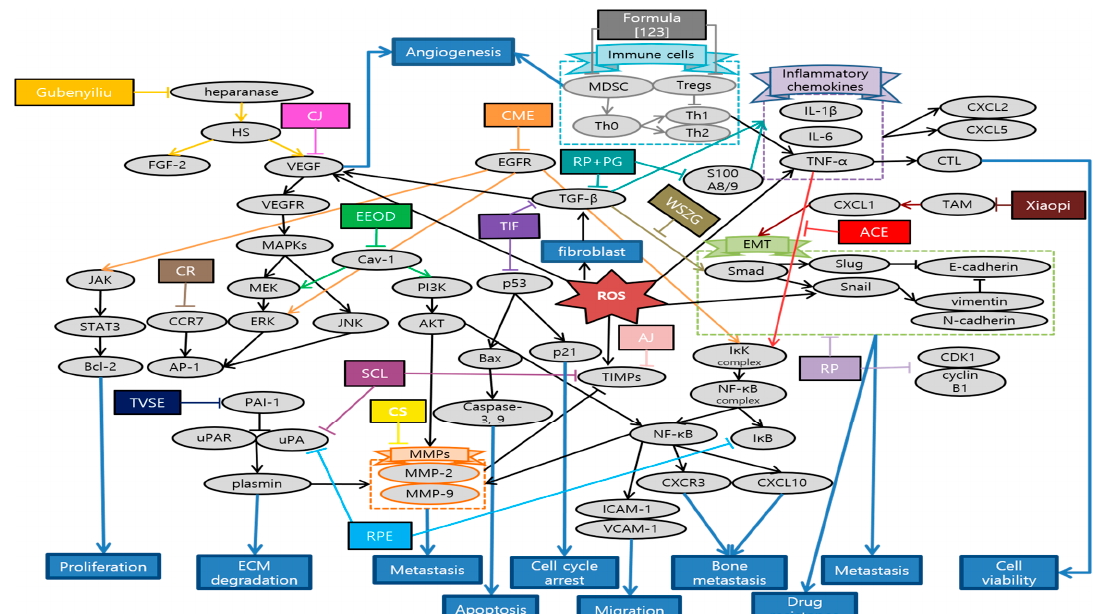
Figure 5. Schematic diagram of anti-metastatic mechanisms of herbal medicine in breast cancer: Herbal medicine suppress metastasis by blocking a series of EMT-related processes which starts with TGF- β 1 and sequentially provoke Smad, Snail, twist, N-cadherin, and, etc. CXCL also mediates EMT which contributes to metastatic micro-environment formation. Moreover, herbal medicine can suppress the expression of MMPs, which play multiple key roles in facilitating the metastasis of tumor cells by direct or indirect pathways. In the latter, MMP-9 is stimulated by various pathways such as AKT/ERK, NF- κ B, STAT3, CCR7-AP-1 pathway, mRNA modulations of uPA and TIMPs. AKT/ERK pathways are also stimulated by Cav-1 and VEGF which is the onset of angiogenesis. On the other hand, NF- κ B induced by TNF- α can activate MMPs, as well as metastasis related factors such as CXCR3-CXCL10, ICAM-1 and VCAM-1. Besides, herbal medicines also stimulate cancer cell apoptosis and cell cycle arrest which are usually mediated by activation of ROS and caspase-3. Expression of CDK1/cyclin B1 and p21 stimulated from p53 were related with cell cycle arrest and apoptosis. Meanwhile, there are two opposite ways in which herbal medicine controls the immune response as anti-metastatic mechanisms. First of all, excessive inflammatory responses create a favorable environment for cancer metastasis. Recombinant S100 calcium-binding protein A8/A9 (S100A8/A9) mobilizes the expressions of pro-inflammatory cytokines including IL-1 β , IL-6, and TNF- α through the production of ROS, which stimulates NF- κ B in peripheral blood mononuclear cells. Furthermore, those inflammatory chemokines produce CXCL2 and CXCL5 which have strong chemotactic capacities on neutrophils. Herbal medicines suppress those excessive immune responses and prevent metastasis. In contrast, building up the overall immune system can upgrade the survival ability of patients. Natural combinations control Tregs and MDSC population, as well as increase the anti-tumor cytokine. This contributes to prolongation of life span. Abbrevation: ACE, Alisma canaliculatum ethanolic extract; AJ, Ampelopsis japonica; CS, Camellia sinensis; CME, Centipeda minima extract; CJ, Cirsium japonicum; CR, Curcumae Radix; EEOD, ethanol extract of Olden diffusa; SCL, Smilax china L.; SN, Solanum nigrum; RPE, Rheum palmatum L. extract; TVSE, Toxicodendron vernicifluum stokes extract; RP, Ruyiping; RP+PG, Ruyiping with Platycodon grandiflorum; TIF, Trametes robiniophila Murr with Radix Isatidis; WSZG, Wensheng